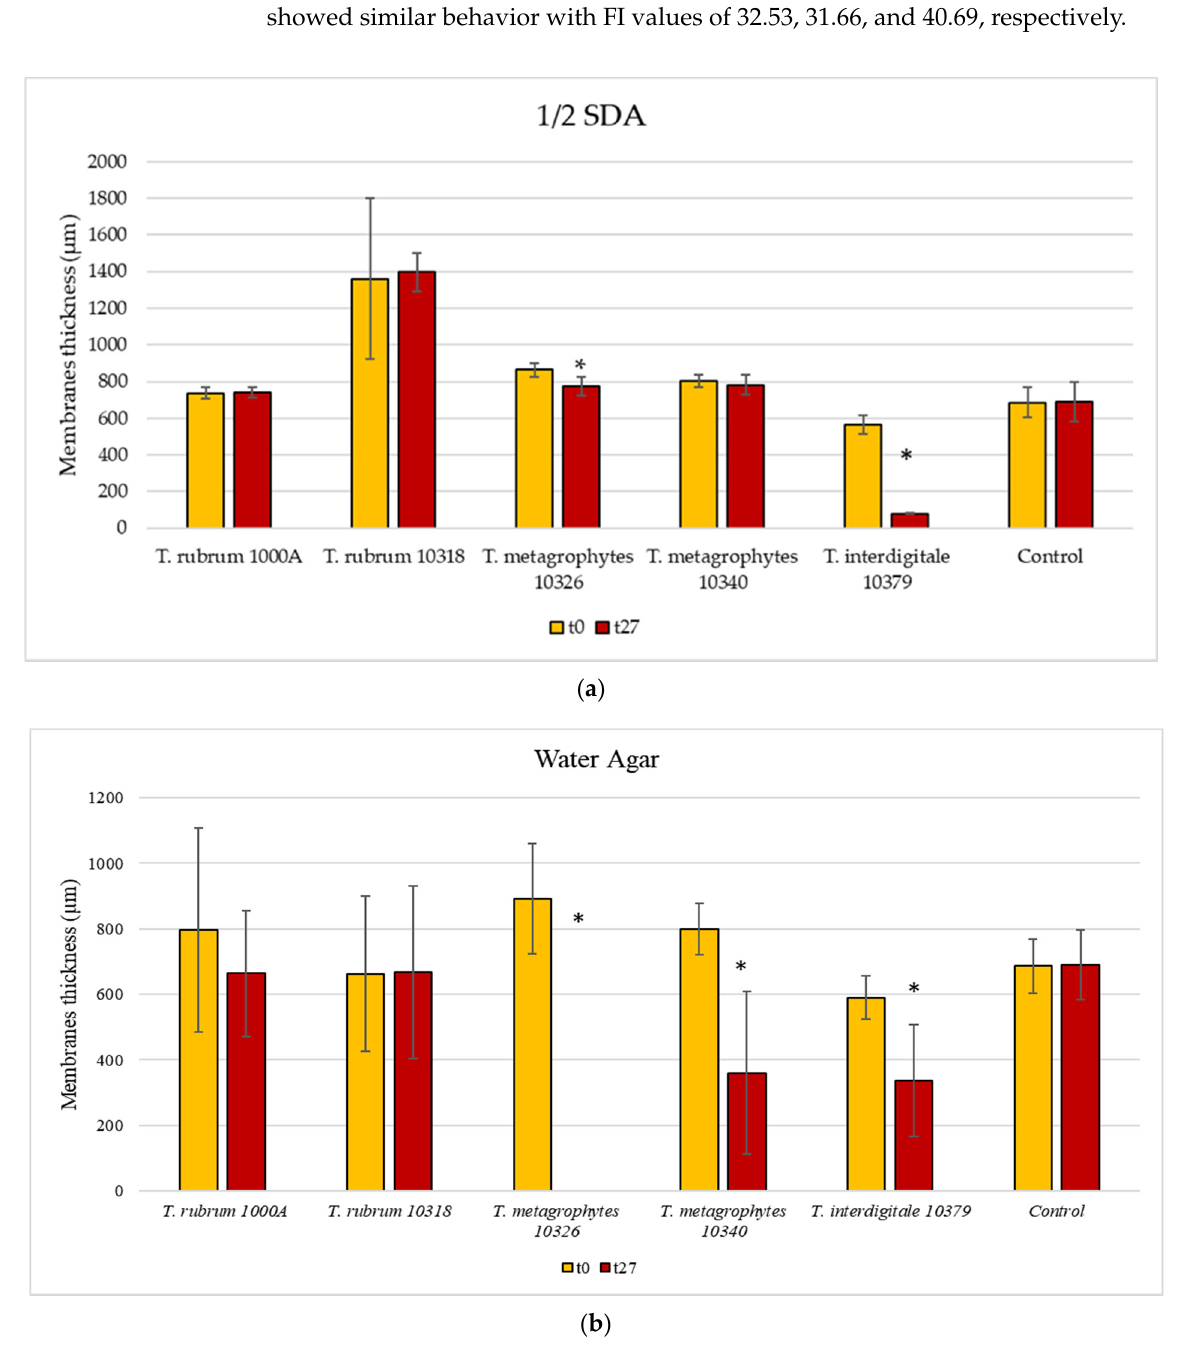
Figure 9. Membrane thickness at time zero (t0) and after 27 days of fungal colonization (t27) in ½ SDA ( a ) and in WA ( b ). Error bars indicate the standard deviation of the three replicates used for the tests. Two-sample paired t -test were performed, and statistically significant differences are marked with *.